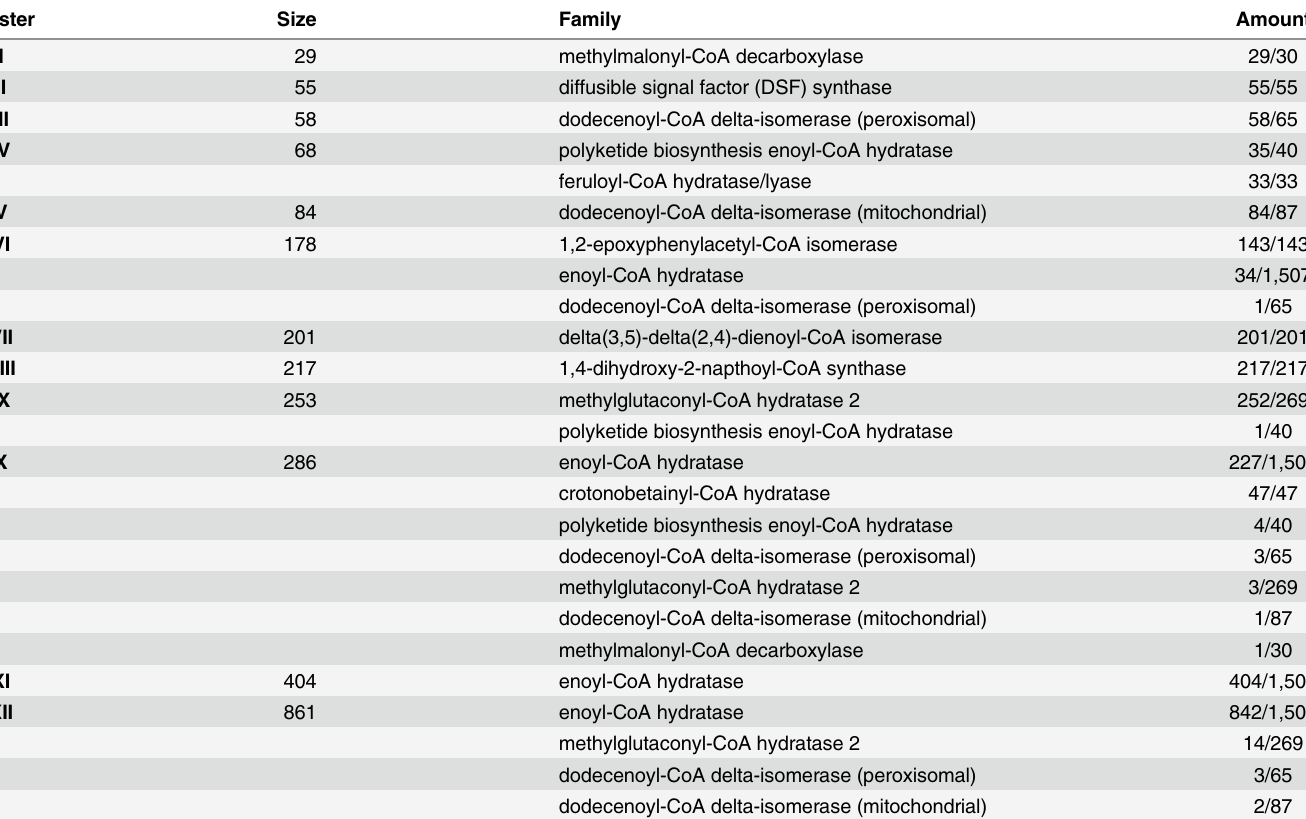
Table 12. Distribution of families among the twelve crotonase superfamily clusters produced by the GP system. Cluster